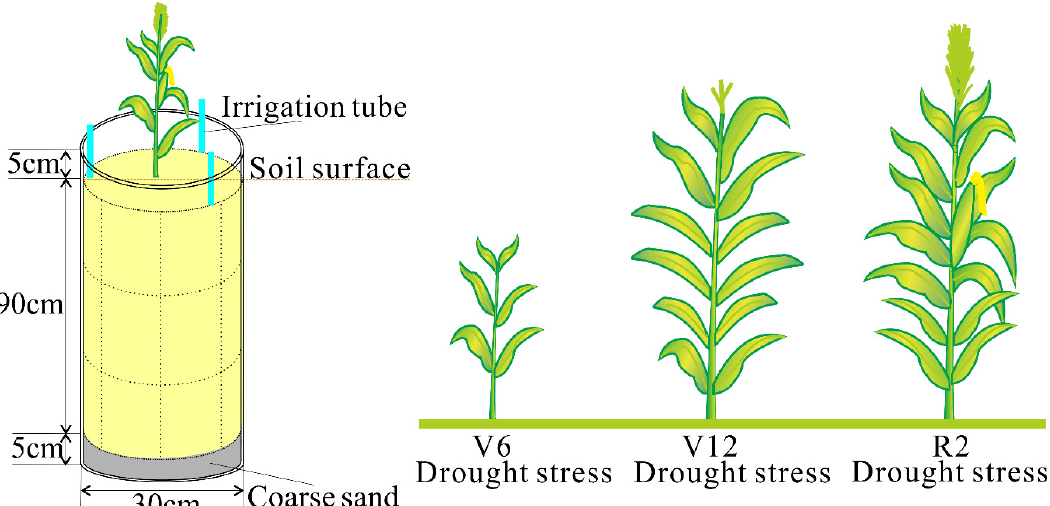
Figure 1. Diagram of an experimental column and the three drought stress periods during the 6-leaf (V6), 12-leaf (V12), and blister (R2) stages.